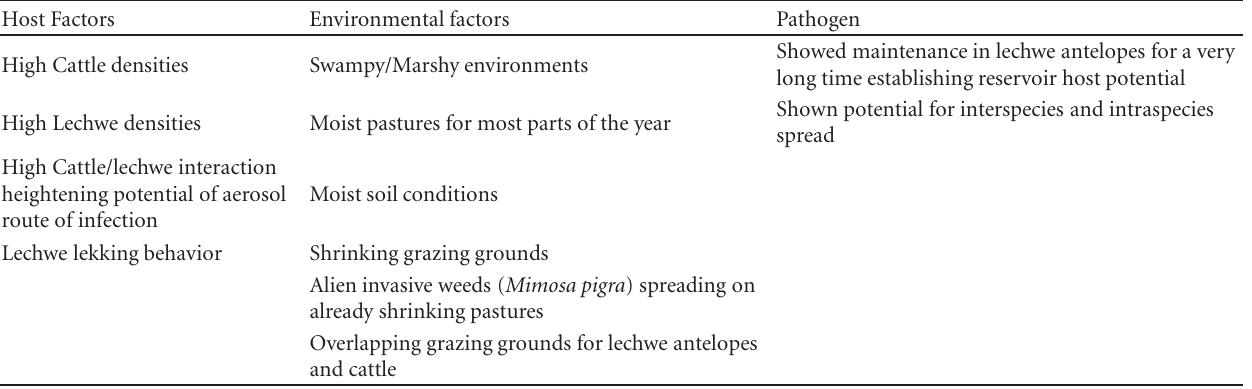
Table 2: Factors influencing BTB in the livestock/wildlife interface areas of the Kafue basin.